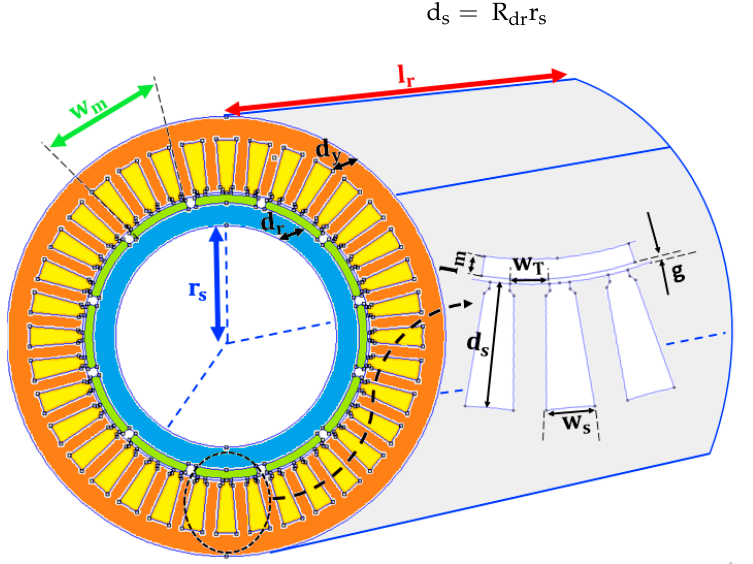
Figure 2. Permanent magnet synchronous generator structural model.